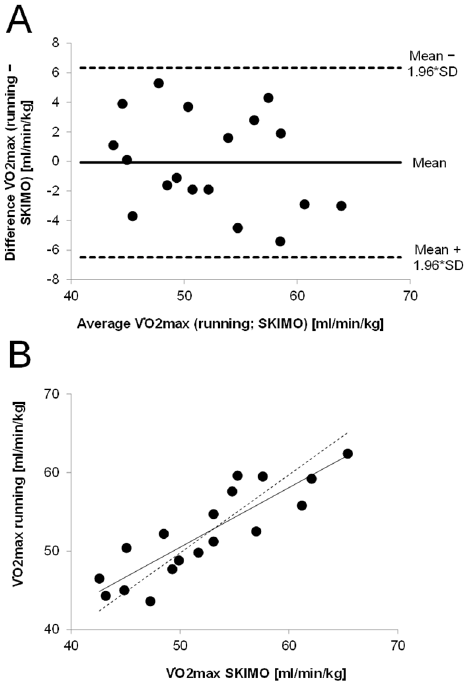
Figure 1. Agreement in VO 2 max values between running and SKIMO. ( A ): Bland–Altman plot showing the differences between running and SKIMO against average VO 2 max values. ( B ): VO 2 max values for uphill running against SKIMO, including regression line (solid) and ideal line (dashed).